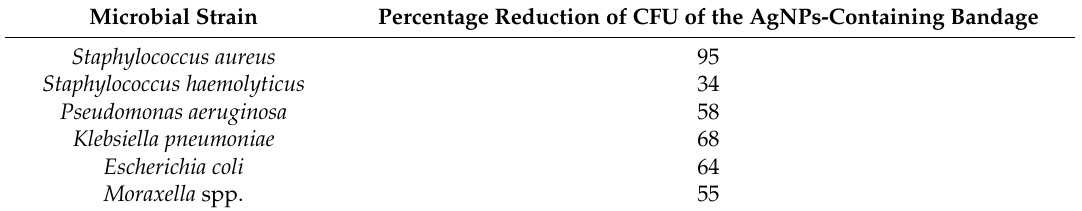
Table 4. Percentage reduction in the number of CFU towards control.